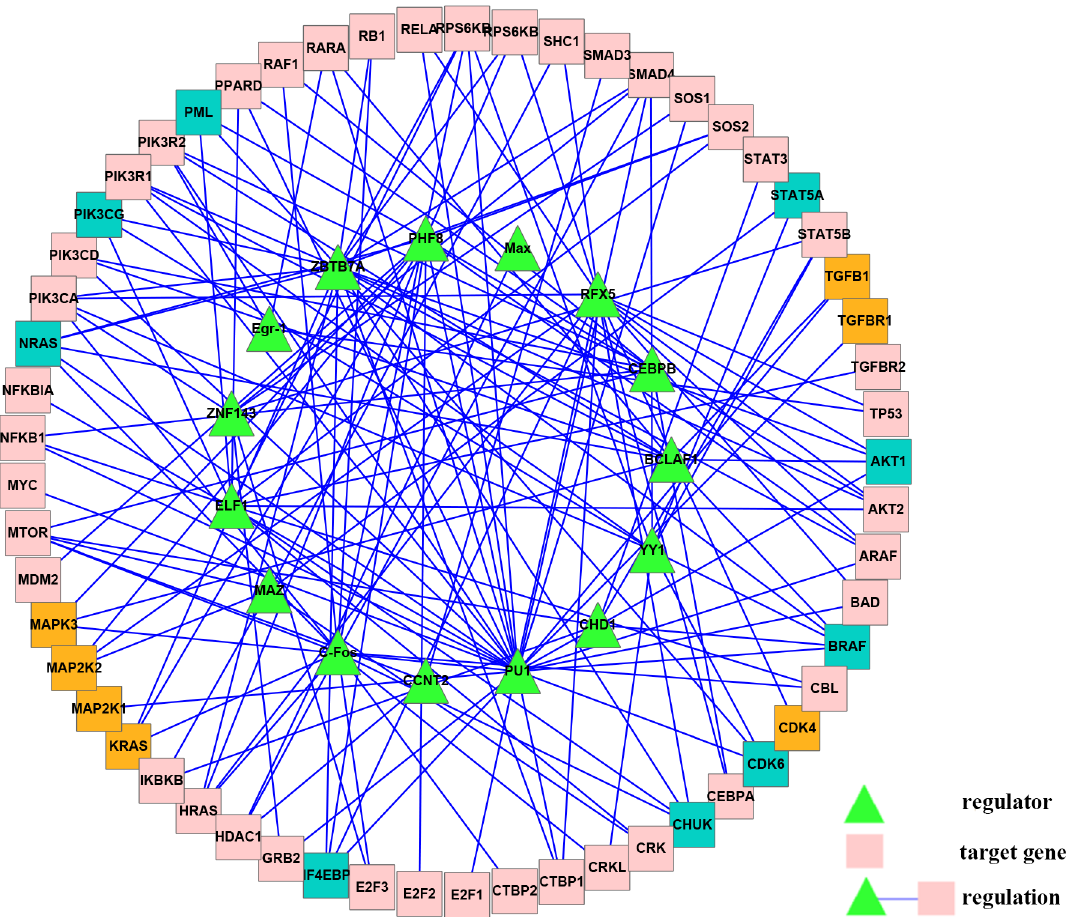
Fig 5. AML-specific gene regulatory network reconstructed by CMI2NI and RPNI. The common target genes are colored in pink. The differential target genes inferred by RPNI and CMI2NI are colored in blue and yellow,